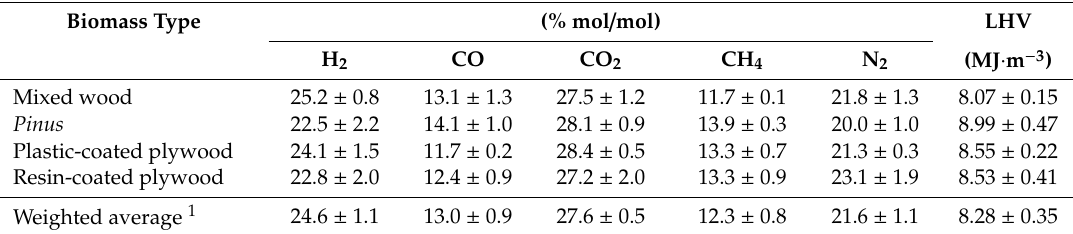
Table 6. Gaseous fuel composition for the 700 ◦ C gasification.